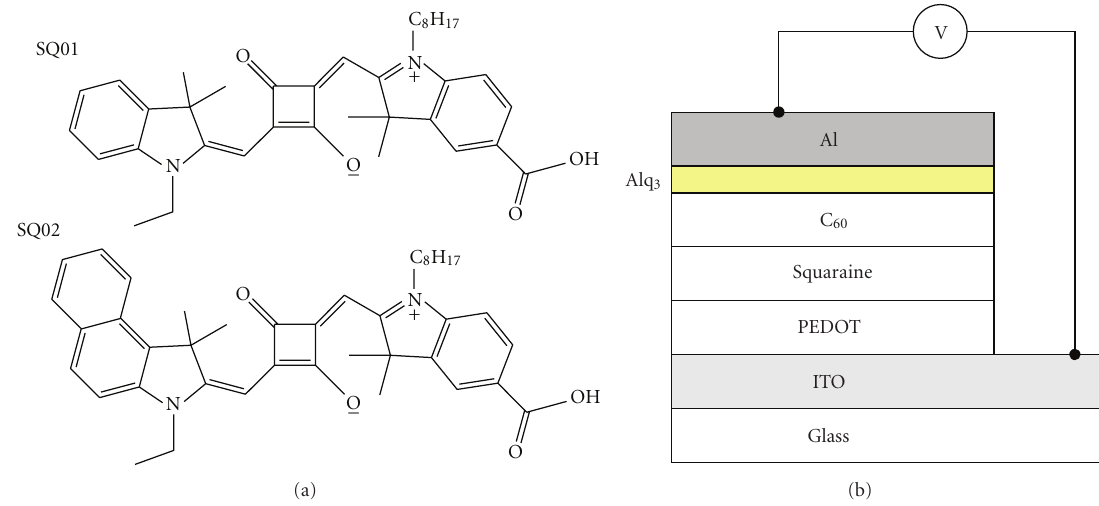
Figure 1: (a) Molecular structure of SQ01 and SQ02. (b) Solar cell architecture.